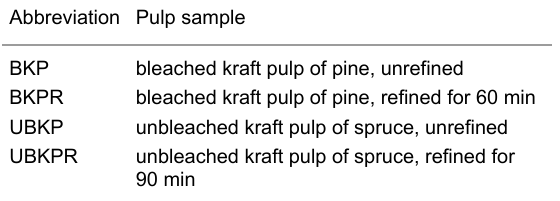
Table 1: The following abbreviations will be used to distinguish the dif- ferent